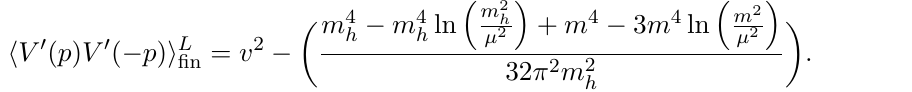
Figure 8 . Second derivative of the vector propagator. All quantities given in units of appropriate powers of the energy scale (cid:22) , with the parameter values e = 1, v = 1 (cid:22) , (cid:21) = 1 and the total (cid:12)nite correction up to (cid:12)rst order in ~ is given